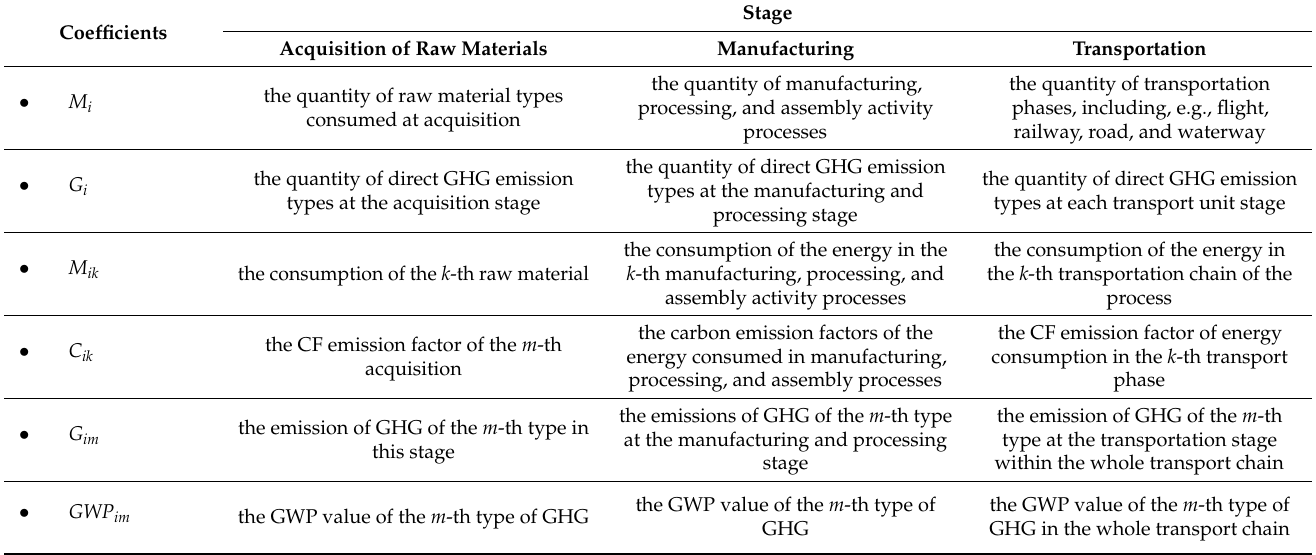
Table 2. The definitions of the variables and coefficients in the CF stages defined in Equations (2)–(4).